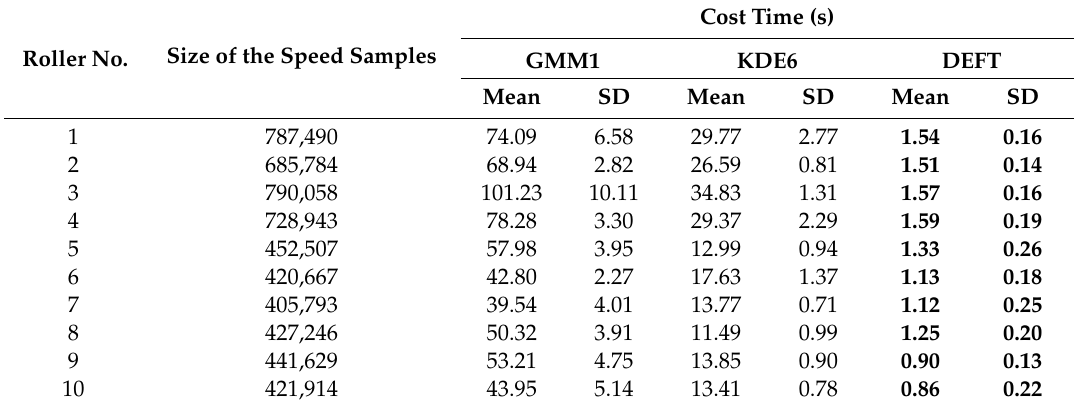
Table 4. The mean and standard deviation of the cost time of di ff erent methods on the probability distribution inference task of ten roller speed